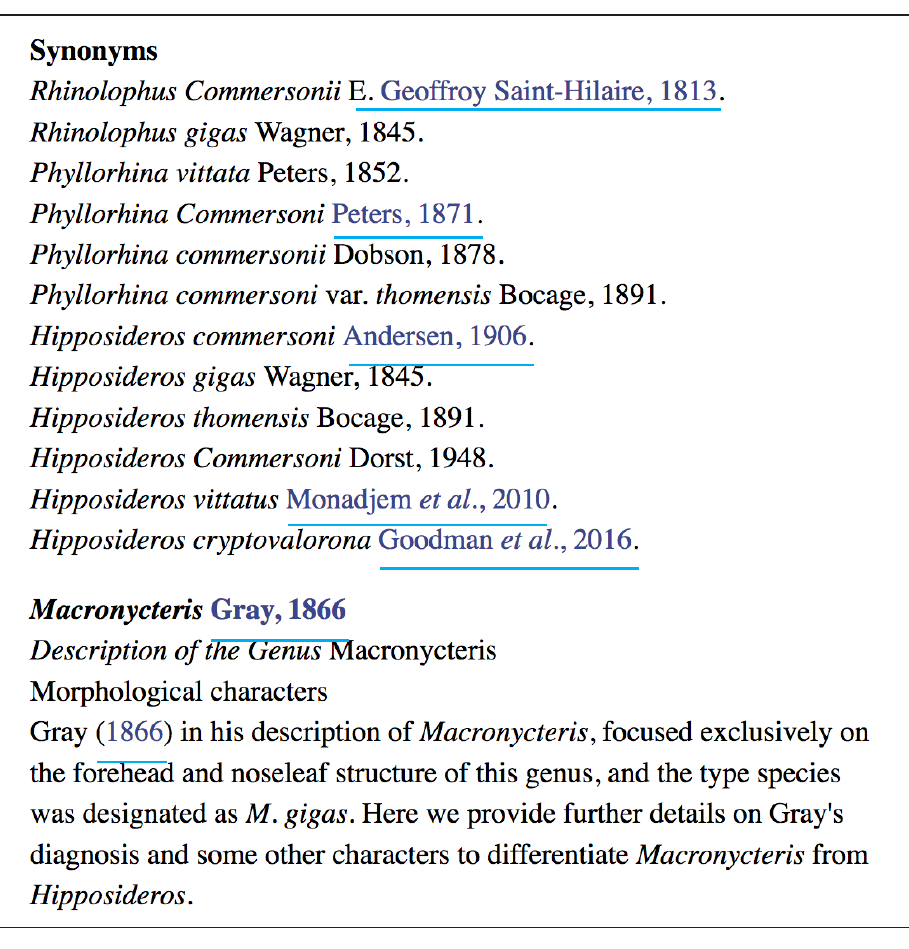
Fig. 11. Underlined in blue are the references linked to the bibliography (considered as such because they are cited in an unambiguous way elsewhere in the text) whereas those in black are not linked because they are not listed in the bibliography (Foley et al. 2017).